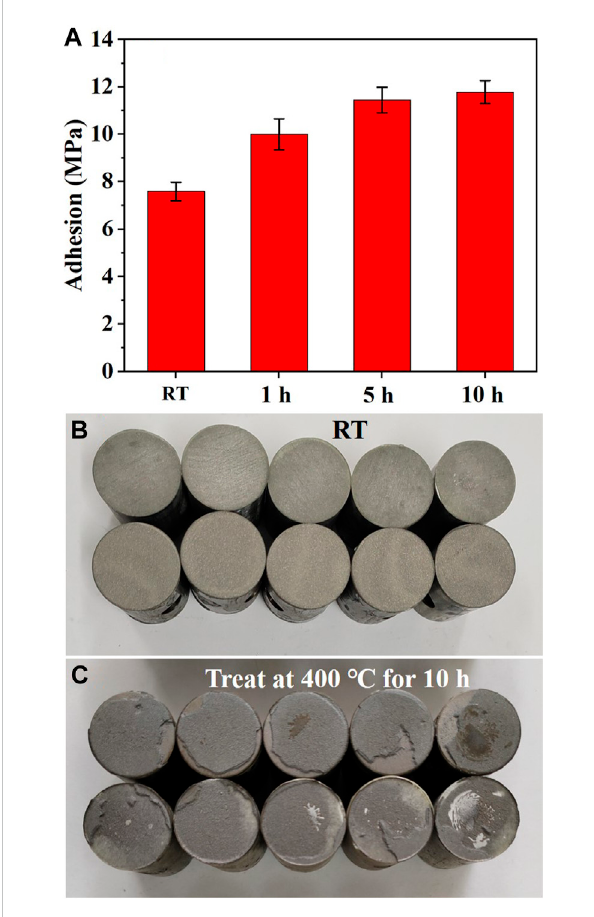
FIGURE 4 (A) Adhesion and (B,C) photos for adhesion test samples of FeCoCr/silicone resin coatings before and after heat treatment at 400 °